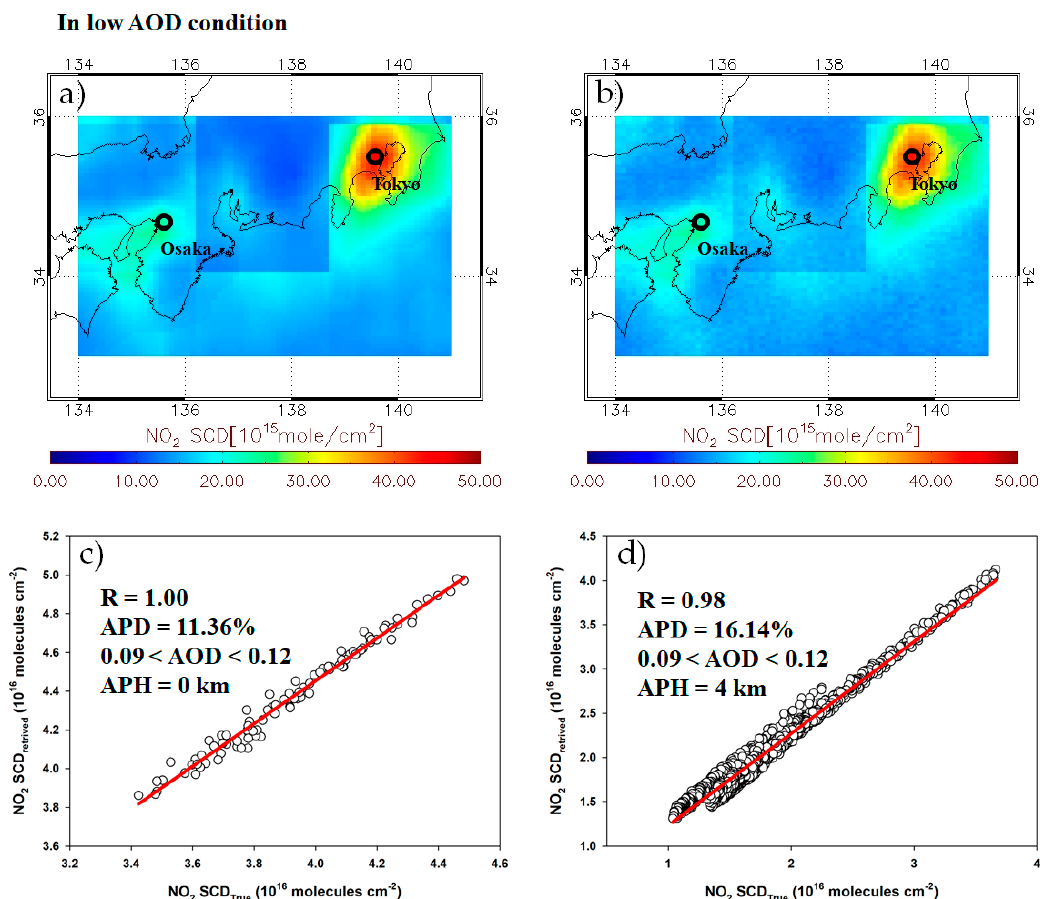
Figure 9. ( a ) True NO 2 SCD, ( b ) retrieved NO 2 SCD, and scatter plots of true and retrieved NO 2 SCD in ( c ) heavily polluted and ( d ) moderately polluted regions in Japan in December 2011 under low-AOD conditions. (Slant column density (SCD) and aerosol optical depth (AOD)).